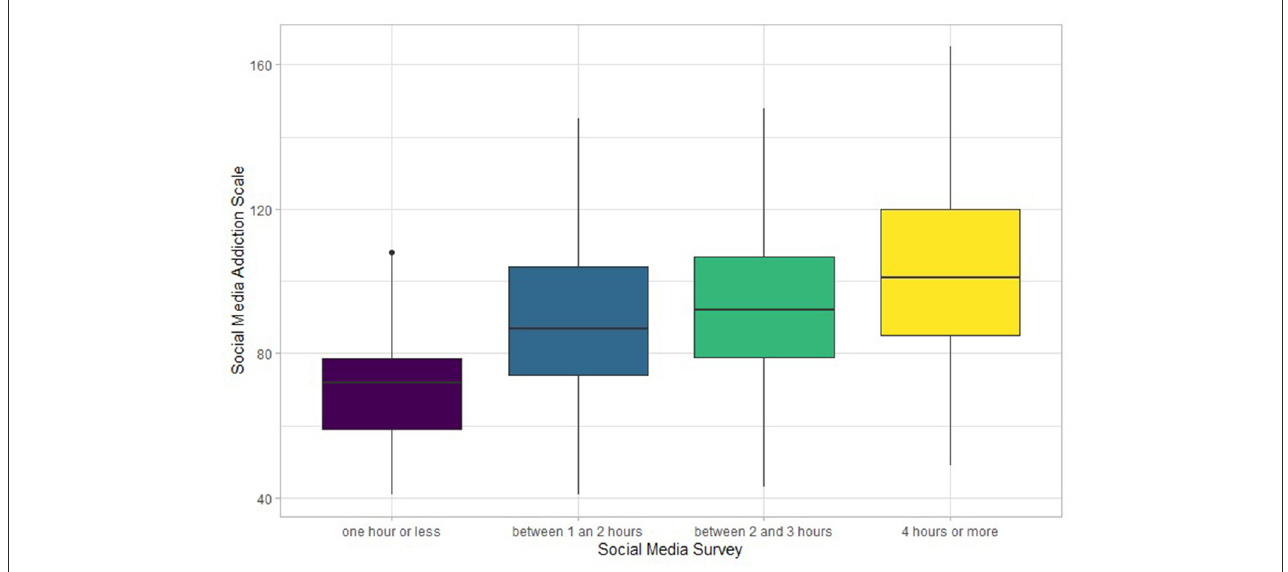
FIGURE3 LSD Test—Social Media Addiction Scale in function of Social Media